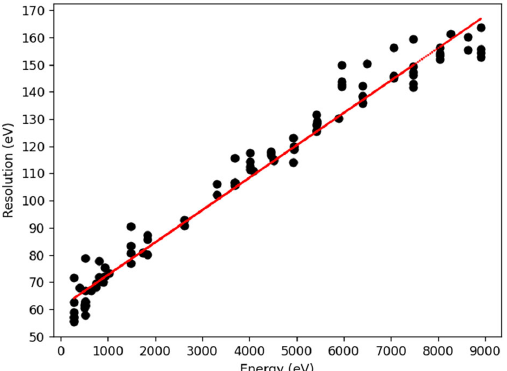
Figure 2. Experimental Determination of the SiriusSD Detector Resolution as a Function of the Photon Energy. The Dispersion of the Data is Mainly Caused by the Use of Different Targets that Induce Different Level of Background and the Possible Presence of Partially Resolved Lines.